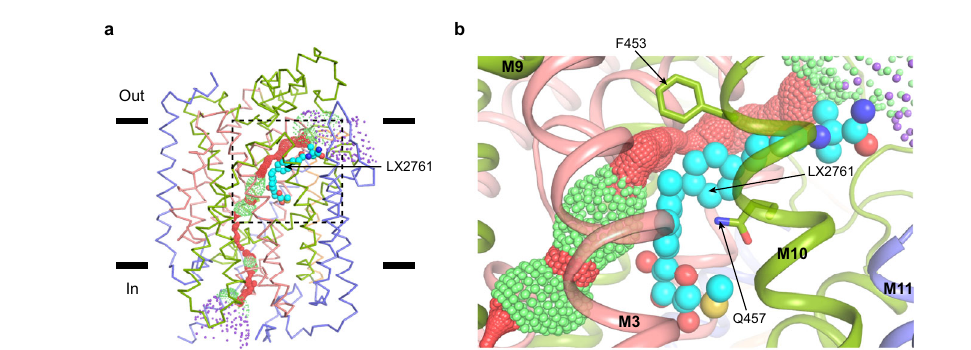
Fig. 5 | Closed water permeation pathway. a The estimated water permeation pathwayofhSGLT1 outward-open isshownassmalldots.Theporeradiiwerecalculated with the HOLE program. Pore radii with <2.8Å, 2.8 Å − 7.8Å, >7.8Å were colored as